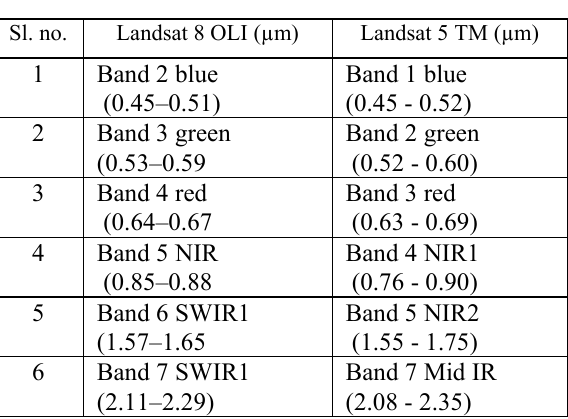
Table 2. Radiometric details of selected satellite